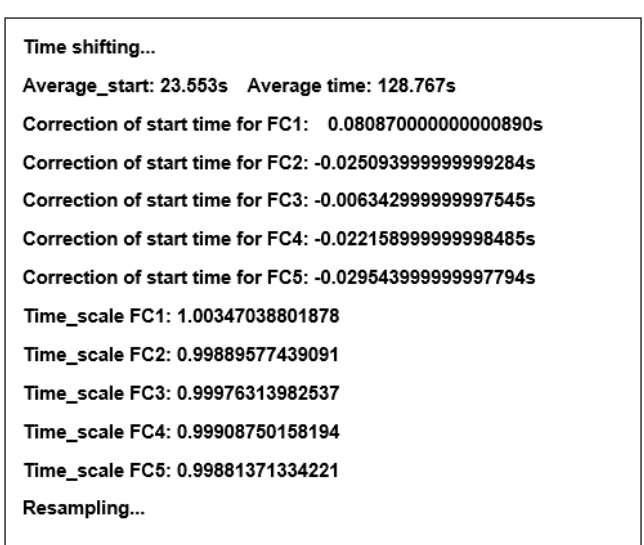
Figure 9. The stages of recording synchronization. This adjustment is made for each recording in the session separately based on the difference between the local start time and the local end time of the recording. The proce- dure is performed automatically by the script written in Python that downloads the data from the sensors. An example of the output of the synchronization procedure is presented in Figure 10.